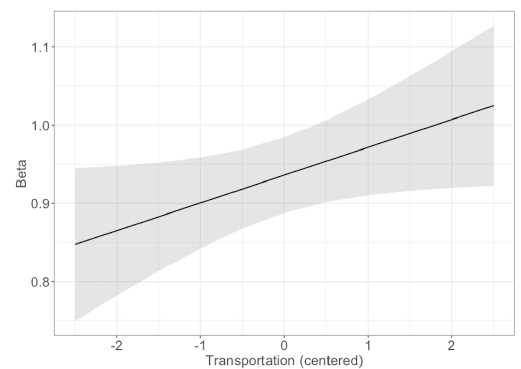
Figure 6. Model estimates for LRTC scaling exponents (β) from the DFA of pupil size fluctuations. The shaded area represents 95% confidence interval.